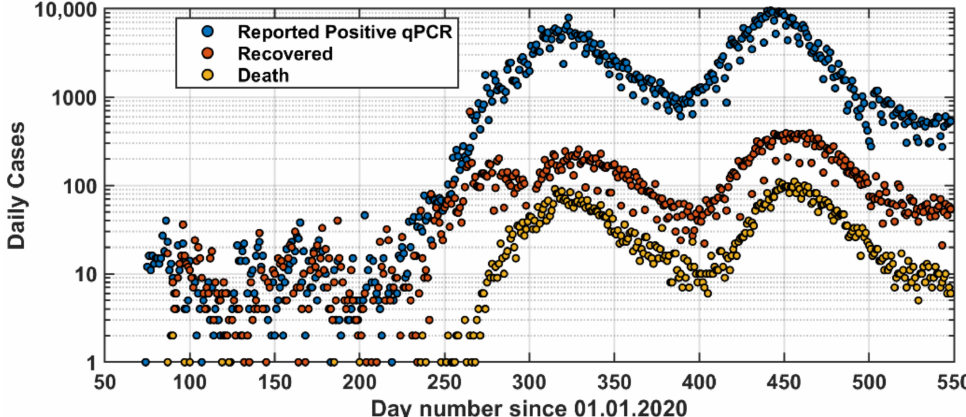
Figure 1. Daily reported cases of positive qPCR tests, recovered, and death since the first case was reported in Jordan (14 March 2020).